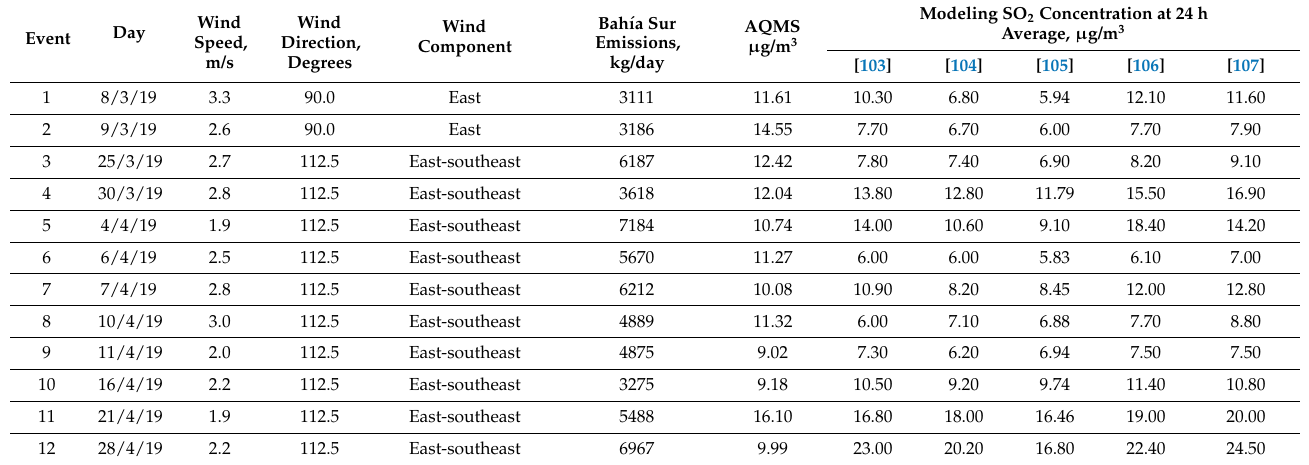
Table 5. SO 2 ambient air concentration ( µ g/m 3 ) using the CALPUFF